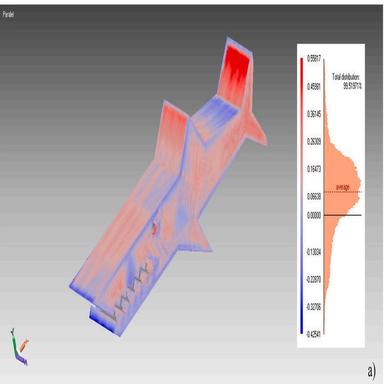
Variance distributions of W14 a) stylized shark and b) octopus.